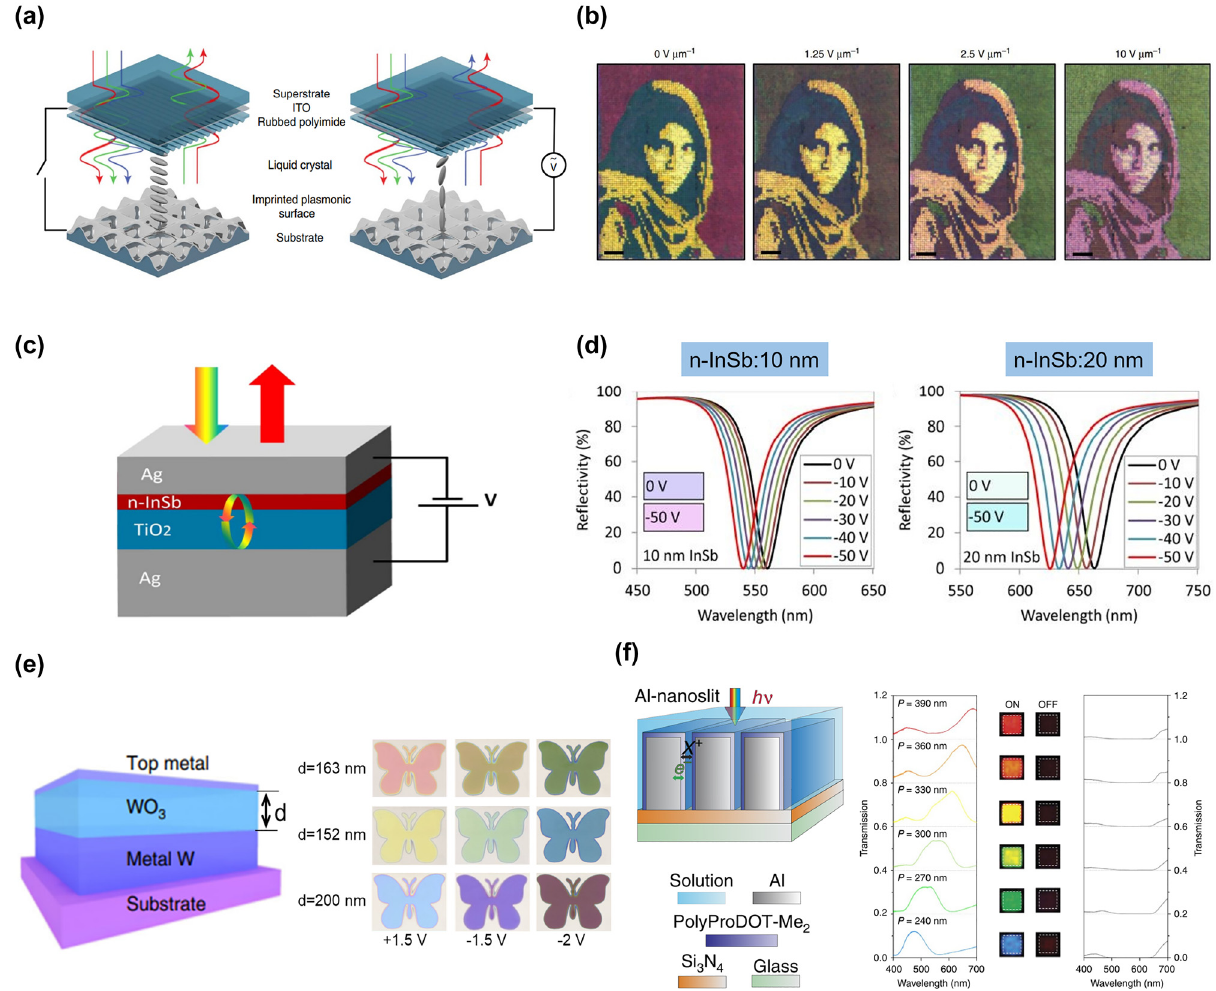
Figure 28: Dynamic structural color generation based on refractive index modulation through external bias voltage. (a) Schematic diagram of the plasmonic liquid crystal (LC) cell. An applied electric field across the cell reorients the liquid crystal and changes wavelengths of the absorbed light. (b) Microscope images of the Afghan Girl, showing reflection colors varying with the applied electric field. Scale bar: 100 μ m. Modified with